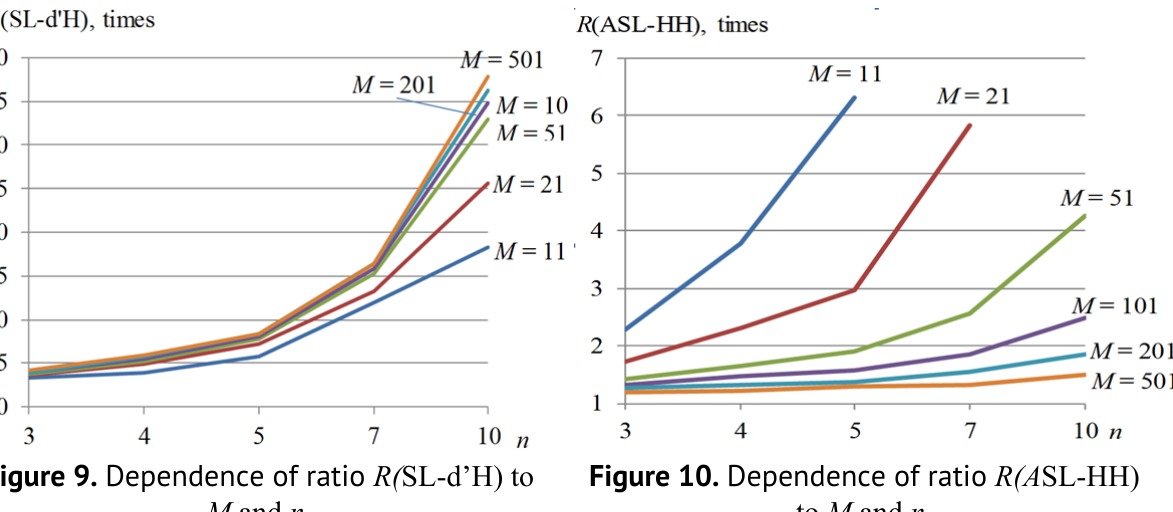
Figure 10. Dependence of ratio R(A SL-HH) to M and n .